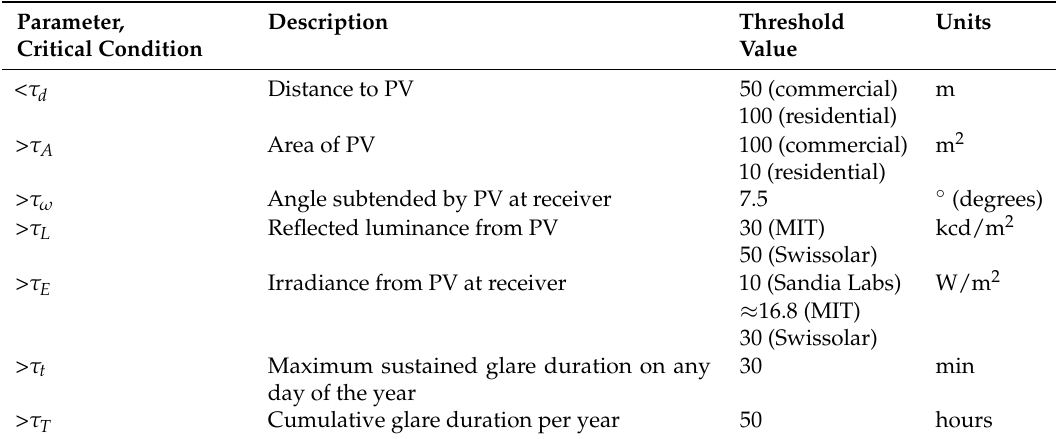
Table 2. Recommended PV reflection assessment criteria and